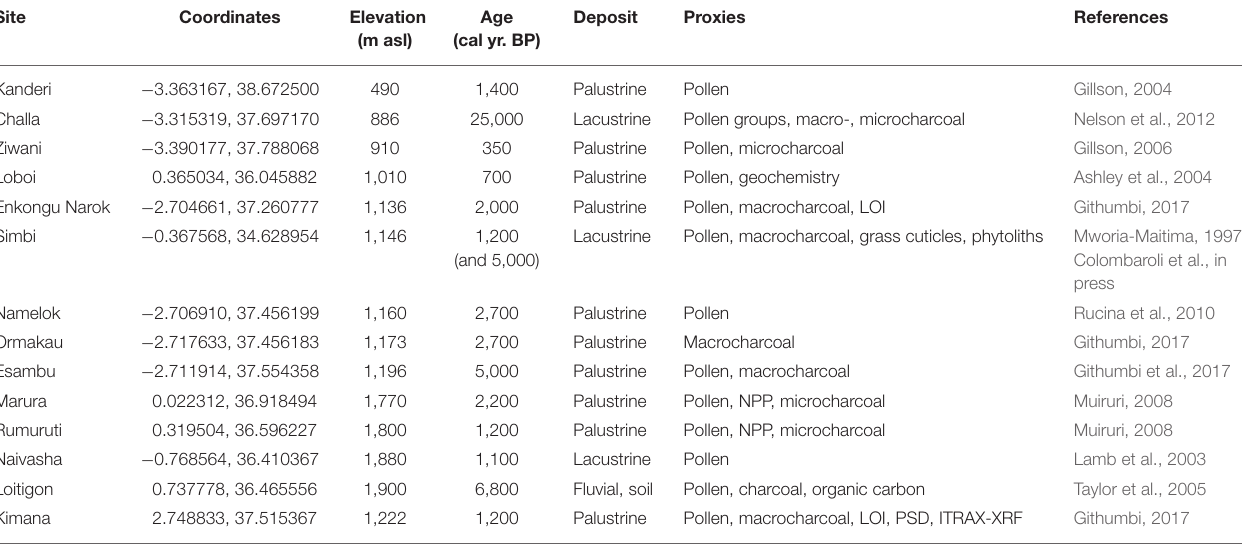
TABLE 1 | Main data from paleovegetation studies derived from woody savannah ecosystems in eastern Africa.